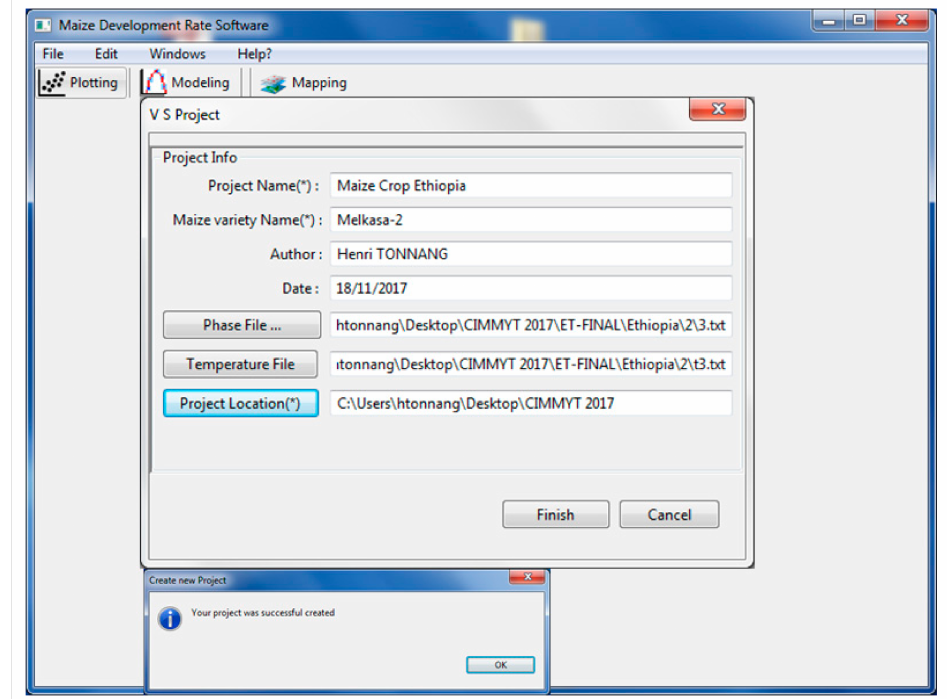
Figure 3. Display of the PPMaP software window for project creation. Under project info,